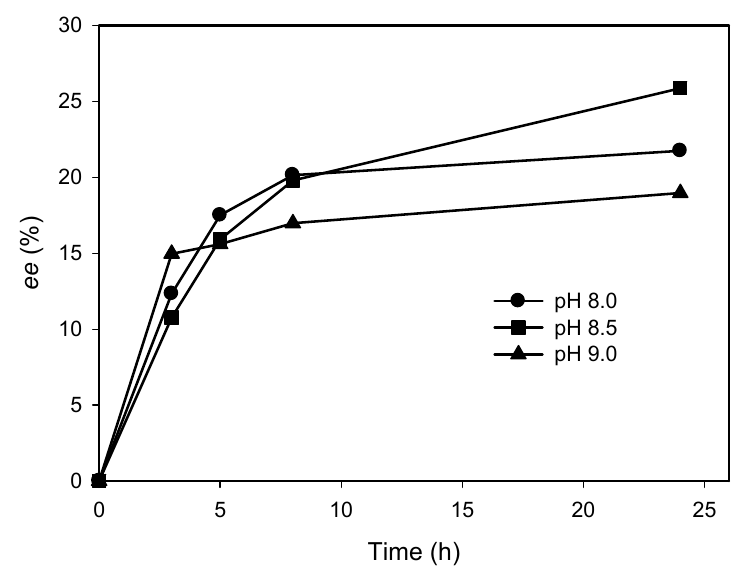
Figure 5. The kinetic resolution of 10 mM a12 . Reaction conditions: 1 mM NAD + , 100 mM Tris/HCl buffer (pH 8.0–9.0), 1 mg/mL of AmDH, and 1 mg/mL of Nox.